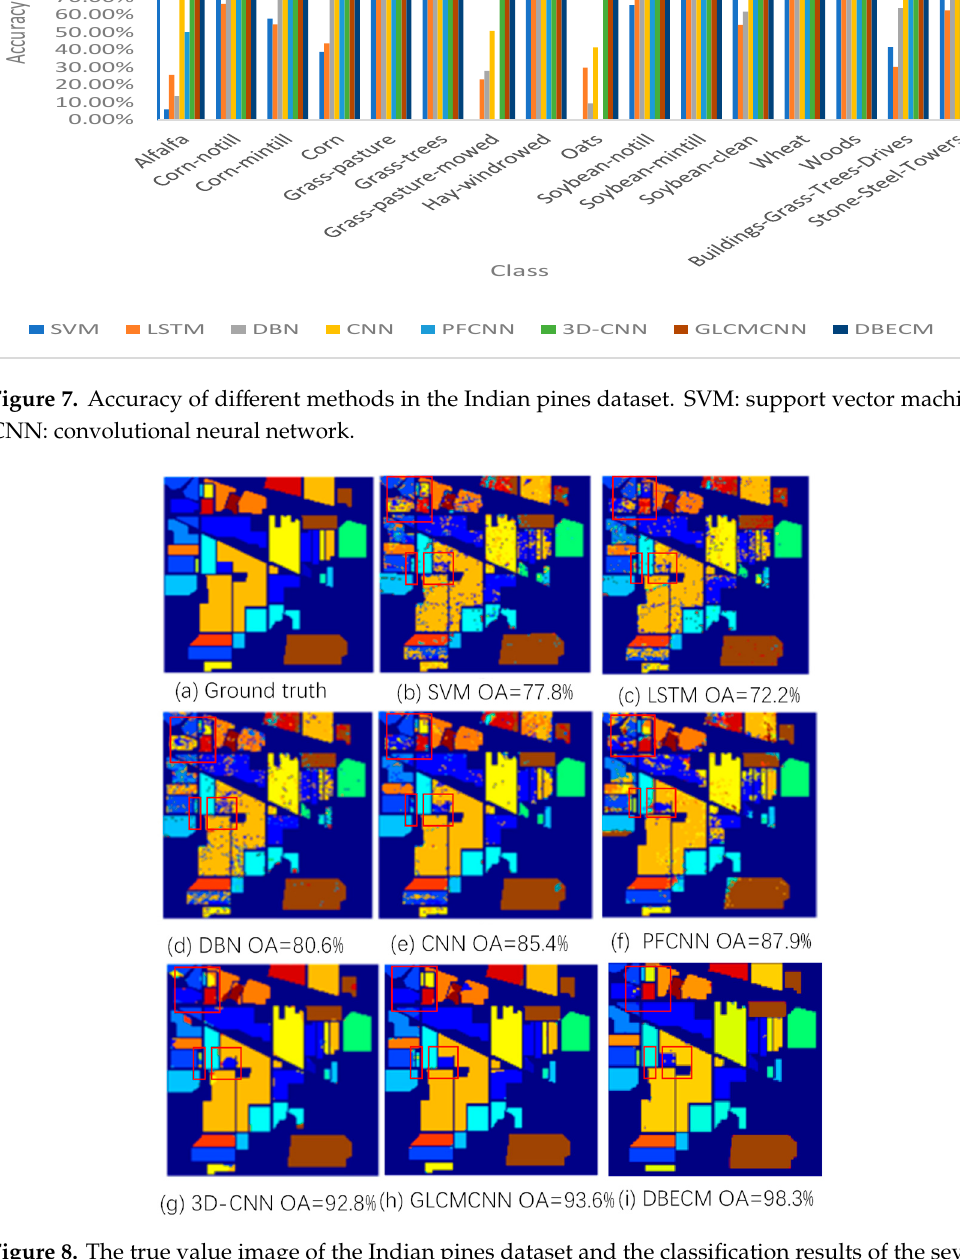
Figure 8. The true value image of the Indian pines dataset and the classification results of the seven methods. ( a ) is a true value image, and ( b – i ) are the classification results of the SVM, LSTM, DBN, CNN, PF-CNN, 3D-CNN, GLCM-CNN, and DBECM. OA: overall average.